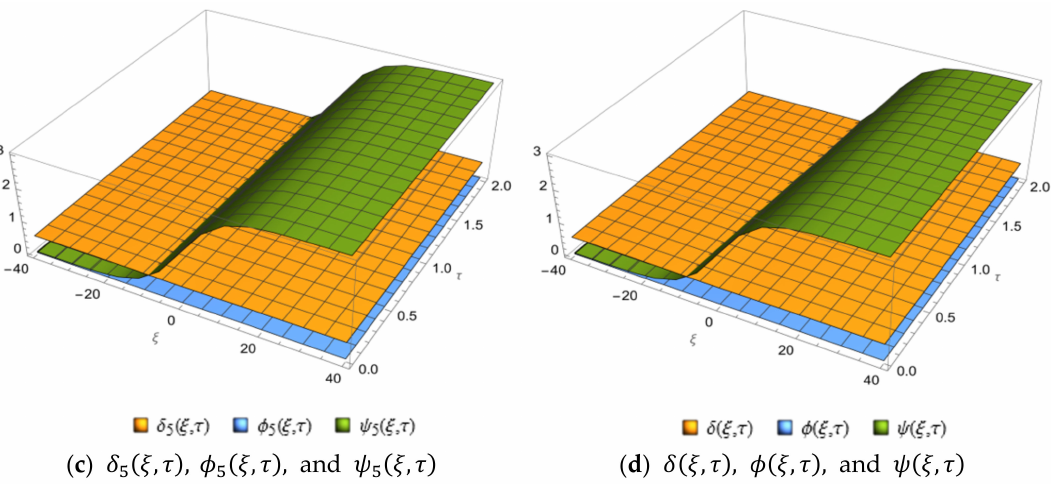
Figure 5. The 3D surface plot of the 10th approximate solutions of u 1 , u 2 , and u 3 at various values of α and t = 0.5 and ζ = 3 for the problem in Example 4.3; ( a ) α = 0.6, ( b ) α = 0.8, ( c ) α = 1, ( d ) α = 1 (exact